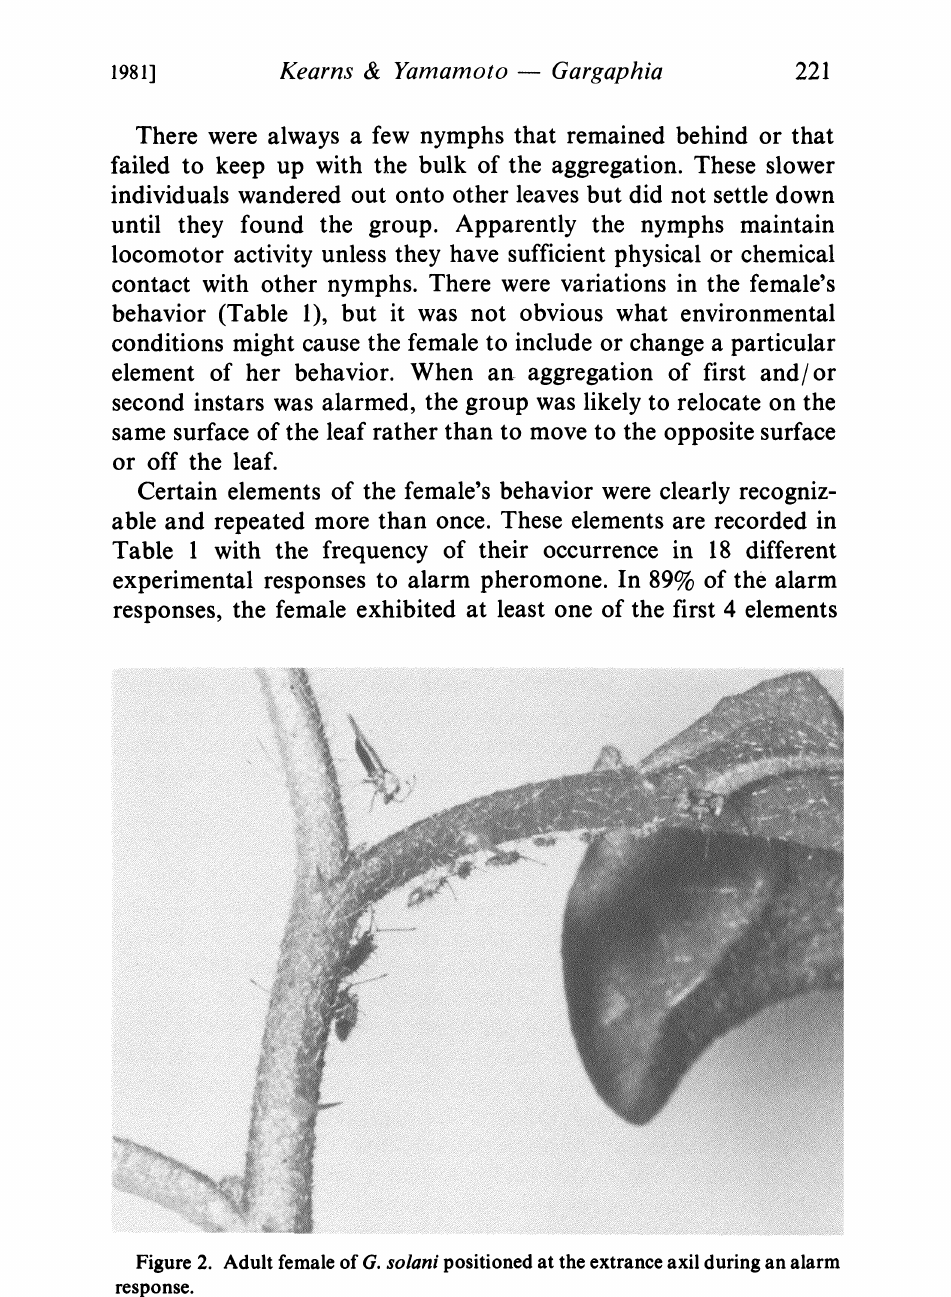
Figure 2. Adult female of G. solani positioned at the extranee axil during an alarm